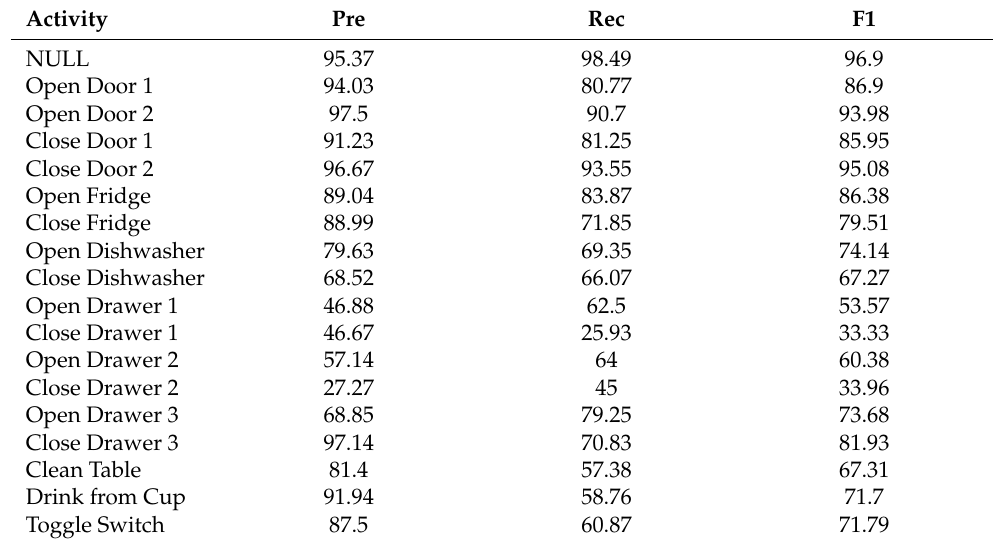
Table 6. Classification rates (%) of the best model of the OPPO dataset using either RF or SVM.